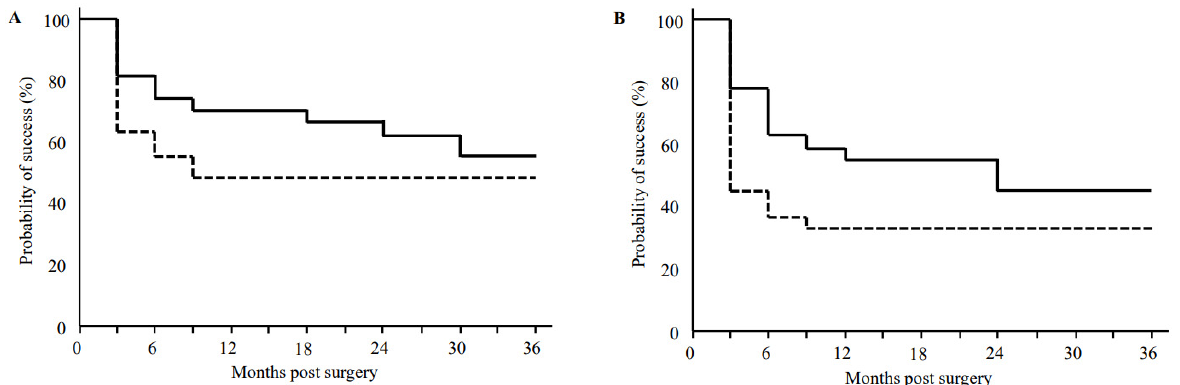
Figure 1. Kaplan–Meier survival curve analysis success rate of IOP control after µ LOT and goniotomy with the KDB in combination with phacoemulsification according to which criterion was used to define failure. Criterion ( A ): 20% reduction in preoperative IOP value, IOP > 18 mmHg, or additional glaucoma surgery. Criterion ( B ): 20% reduction in preoperative IOP value, IOP > 14 mmHg, or additional glaucoma surgery. Solid line: µ LOT-Phaco group, Dashed line: KDB-Phaco group. The numbers of patients considered to be successful for criteria A (success/total) were 20/25, 19/24, 15/23, 12/16, 9/12, and 8/12 at 6M, 12M, 18M, 24M, 30M, and 36M, respectively, in the µ LOT-Phaco group and 15/27, 13/27, 11/23, 7/19, 6/17, and 5/14 at 6M, 12M, 18M, 24M, 30M, and 36M, respectively, in the KDB-Phaco group. For criteria B, the numbers considered to be successful (success/total) were 17/25, 15/24, 11/23, 6/16, 4/12, and 3/12 at 6M, 12M, 18M, 24M, 30M, and 36M, re-